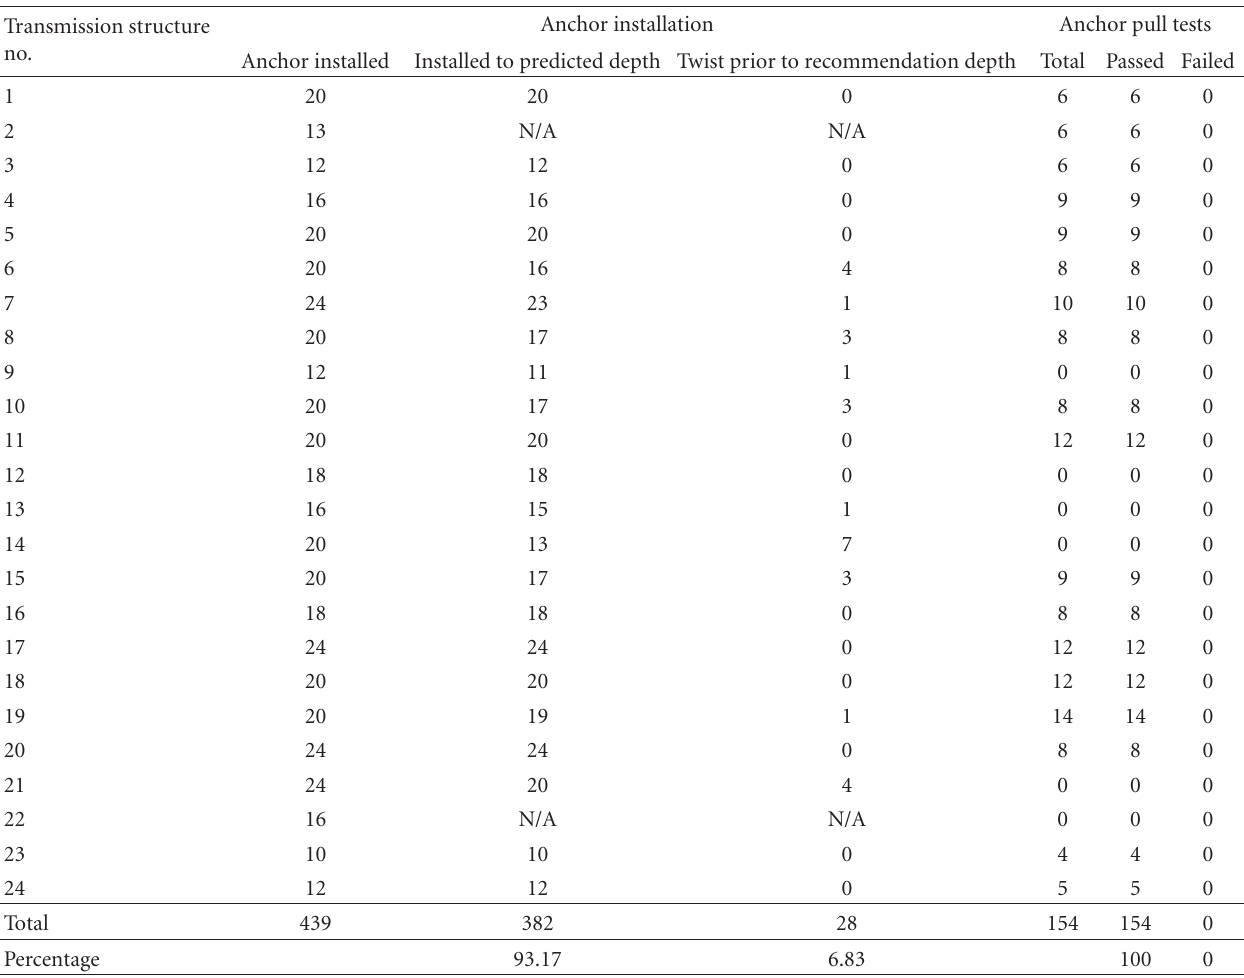
Table 3: Summarized of anchor installation and anchor pull tests at the recent pilot tests. Transmission